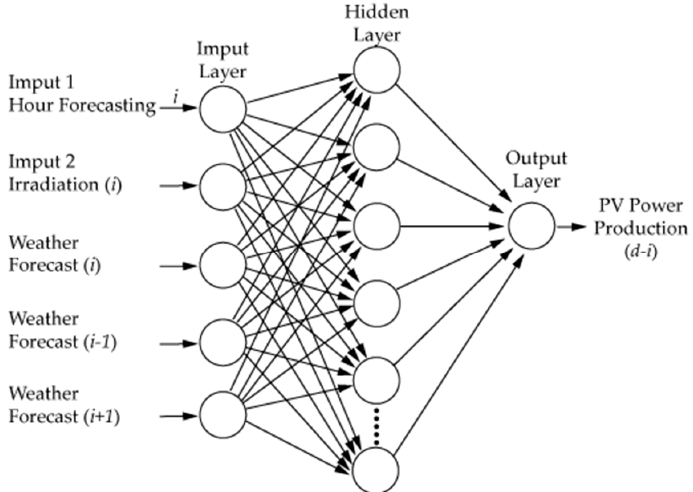
Figure 1. Artificial neural network (ANN) structure for the photovoltaic (PV) forecasting method.